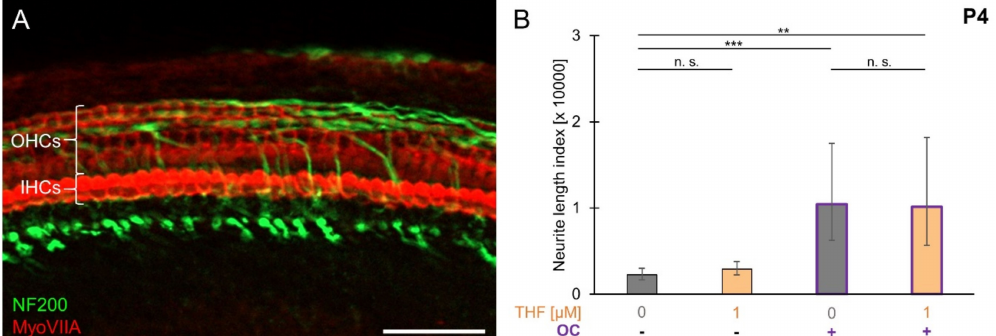
Figure 6. THF e ffi cacy with compounds released from the organ of Corti. SGEs from P4 cochleae were cultured in medium supplemented with 1 µ M THF or devoid of neurotrophic compounds. Additionally, SGEs were cultured together with whole P4 OC explants in a spiral ganglion / organ of Corti (SG / OC) co-culture. SG / OC co-cultures were cultured in medium devoid of neurotrophic compounds or supplemented with 1 µ M THF. ( A ) A detailed image of a P4 OC explant fixed and stained directly after dissection is shown. OC explants were stained for NF200 (green: neuronal fibers) and MyoVIIA (red: hair cells). Scale bar: 50 µ m. ( B ) After 4 DIV, explants were fixed and stained for NF200. Neurite outgrowth from SGEs was quantified. Bars represent geometric means in µ m; error bars indicate ± upper and lower 95% confidence intervals for the mean one-way ANOVA, Tukey–Kramer post-hoc test, n. s. = not significant ( p > 0.05), ** p < 0.01, *** p <